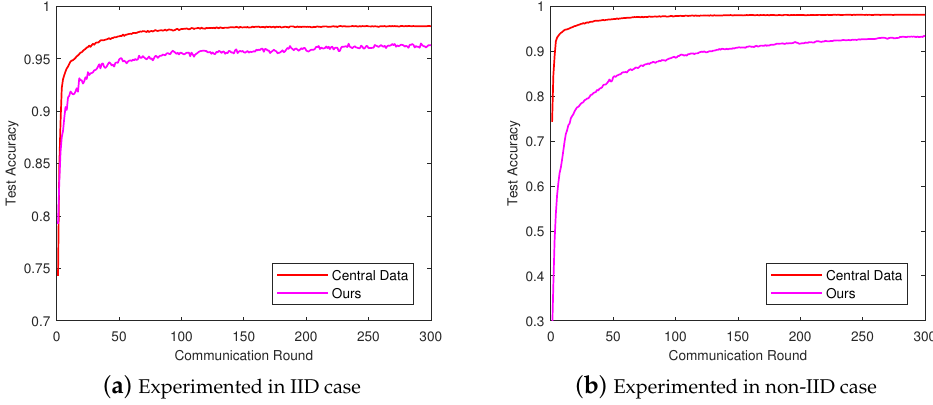
Figure 4. Accuracy comparison of FL for MNIST data set in IID and non-IID cases.